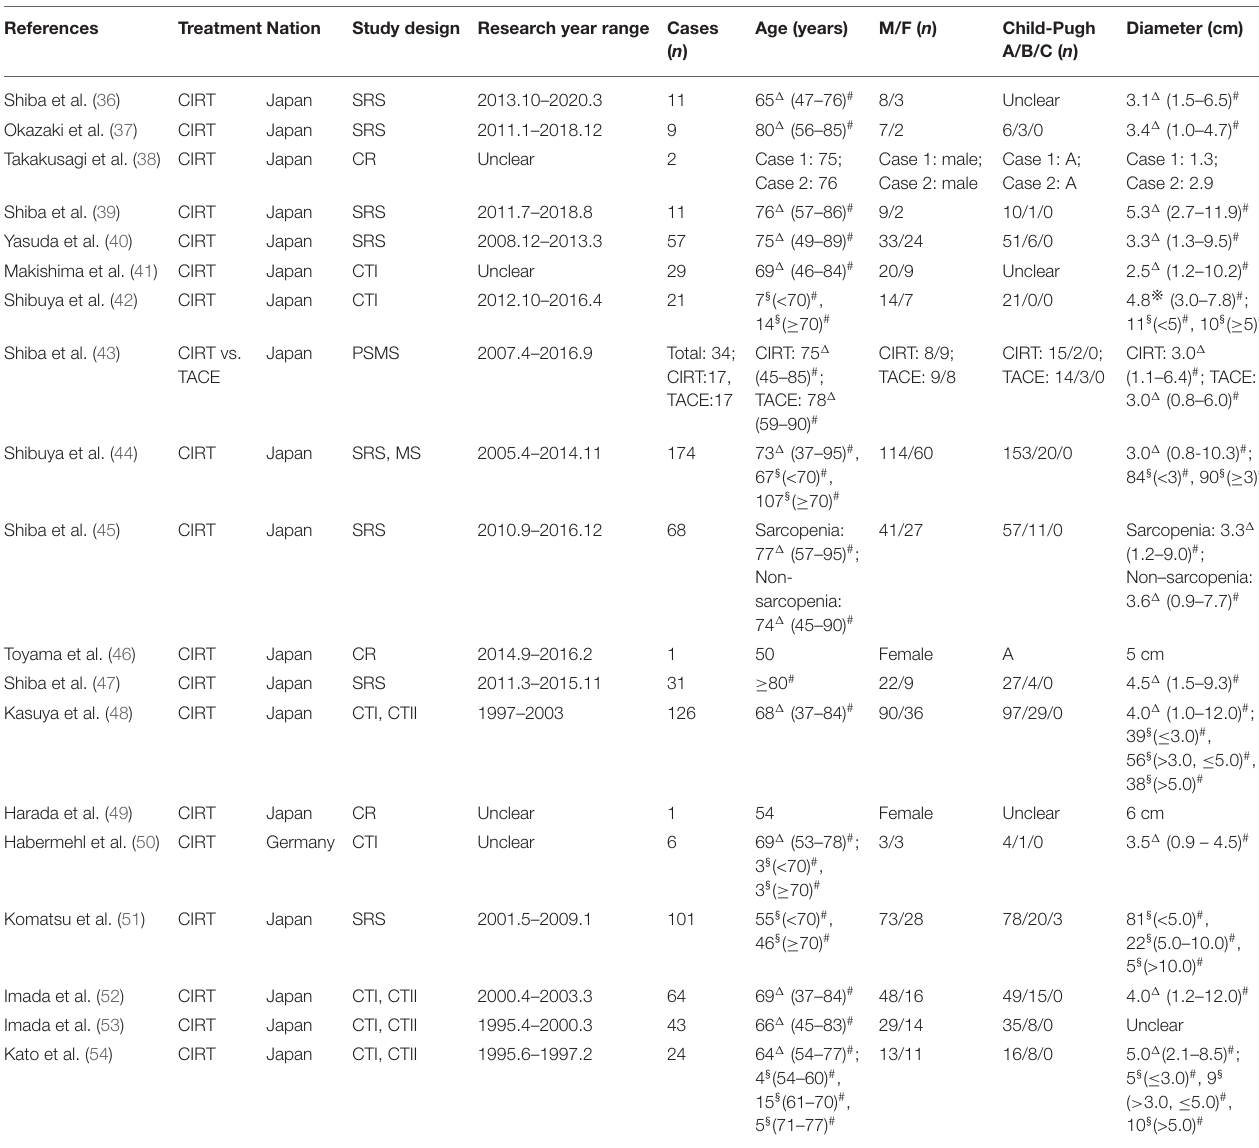
TABLE 1 | Assessment of the basic characteristics of the 19 included